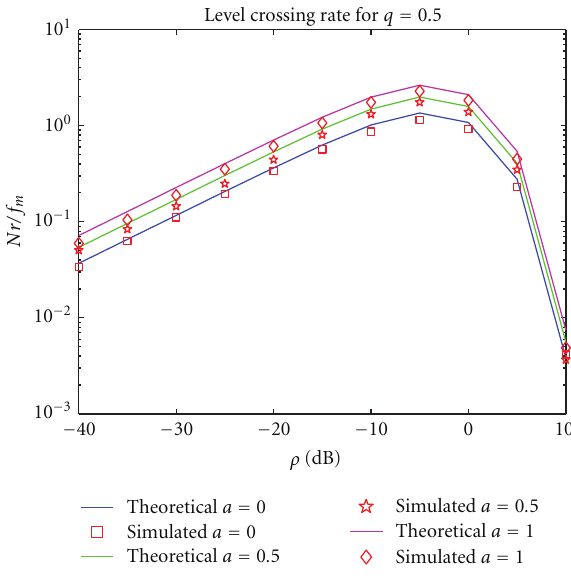
Figure 9: Squared Autocorrelation function of Real part for q = 0 . 5, k = 3.